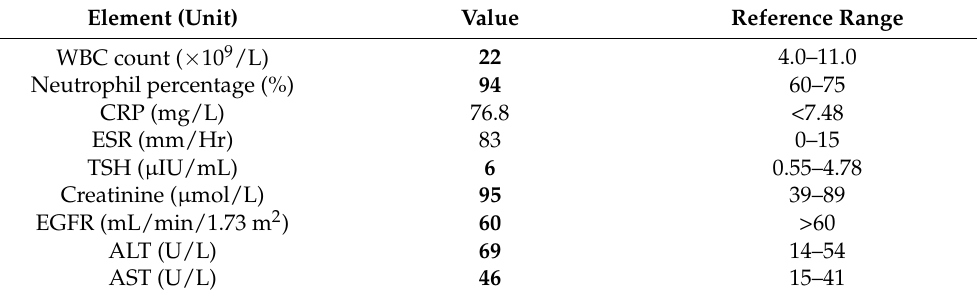
Table 4. Summary of the laboratory investigations of the fourth